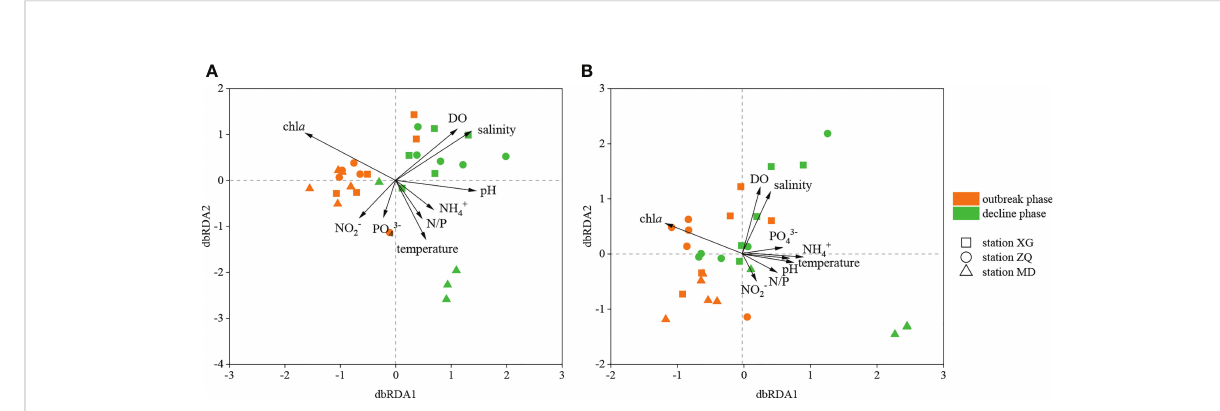
FIGURE 5 db-RDA analysis of the nirK -type (A) and nirS -type (B) denitrifying bacterial communities with physicochemical factors during the green tide in coastal Qingdao